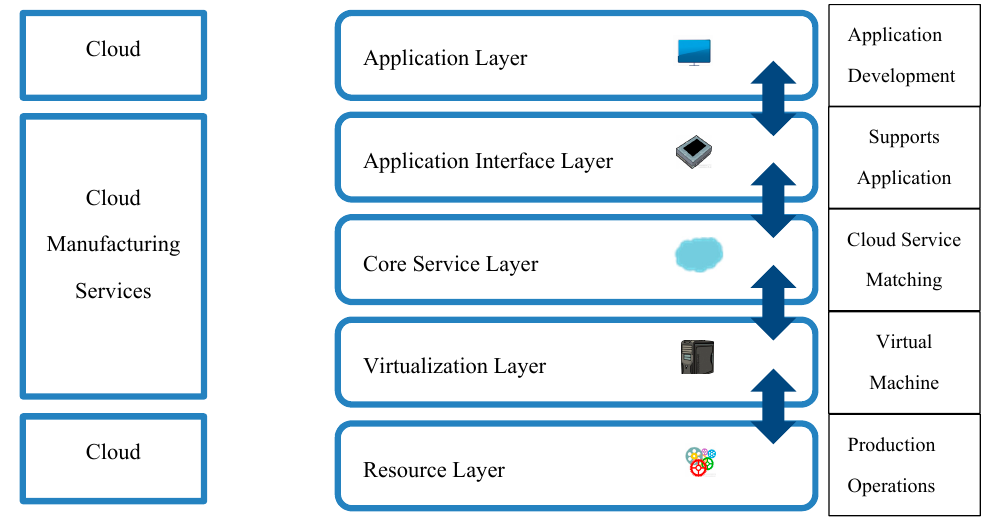
Figure 2. A generic cloud manufacturing